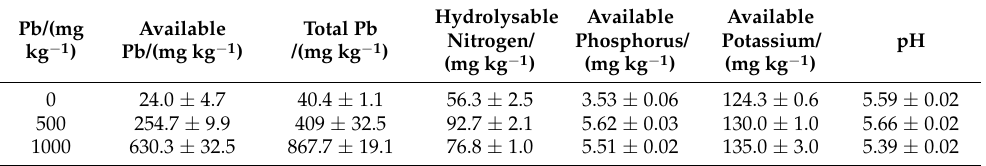
Table 1. Chemical characteristics of test soil. Each value represents the mean of three replicates ± SD. The same